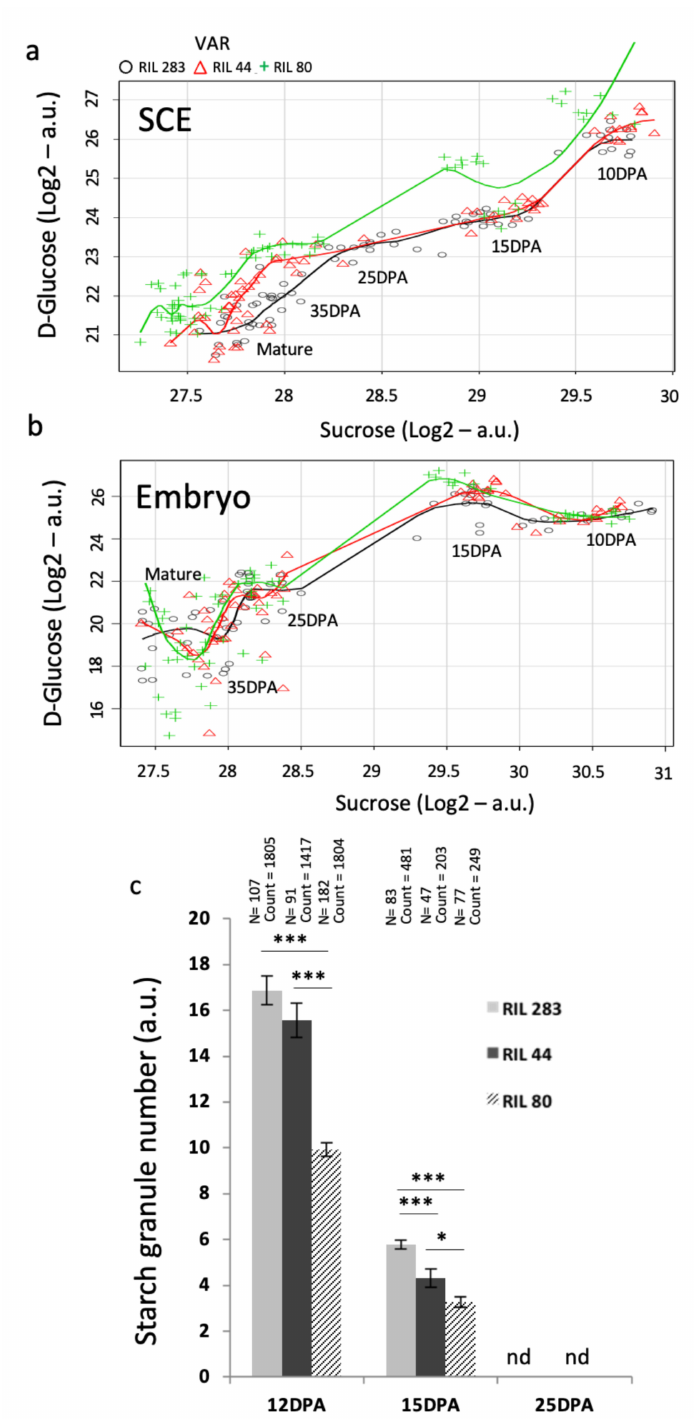
Figure 6. Analysis of the differential use of the main carbon sources in flax RILs during development. ( a ) Evolution of the sucrose and glucose contents in the SCE. Data are from 1H-NMR experiments. Values are means (Log2 transformed) calculated with 10 to 18 biological replicates. ( b ) Evolution of the sucrose and glucose contents in the embryo. Data are from 1H-NMR experiments. Values are means (Log2 transformed) calculated with 10 to 18 biological replicates. ( c ) Starch granules count in the seed coat mucilage secretory cells. Kruskal-Wallis H -test followed by a Mann–Whitney U -test, * p < 0.05, *** p < 0.001. Starch granules count is based on segmentation image analysis using ImageJ software. N, number of cells analyzed. nd, not